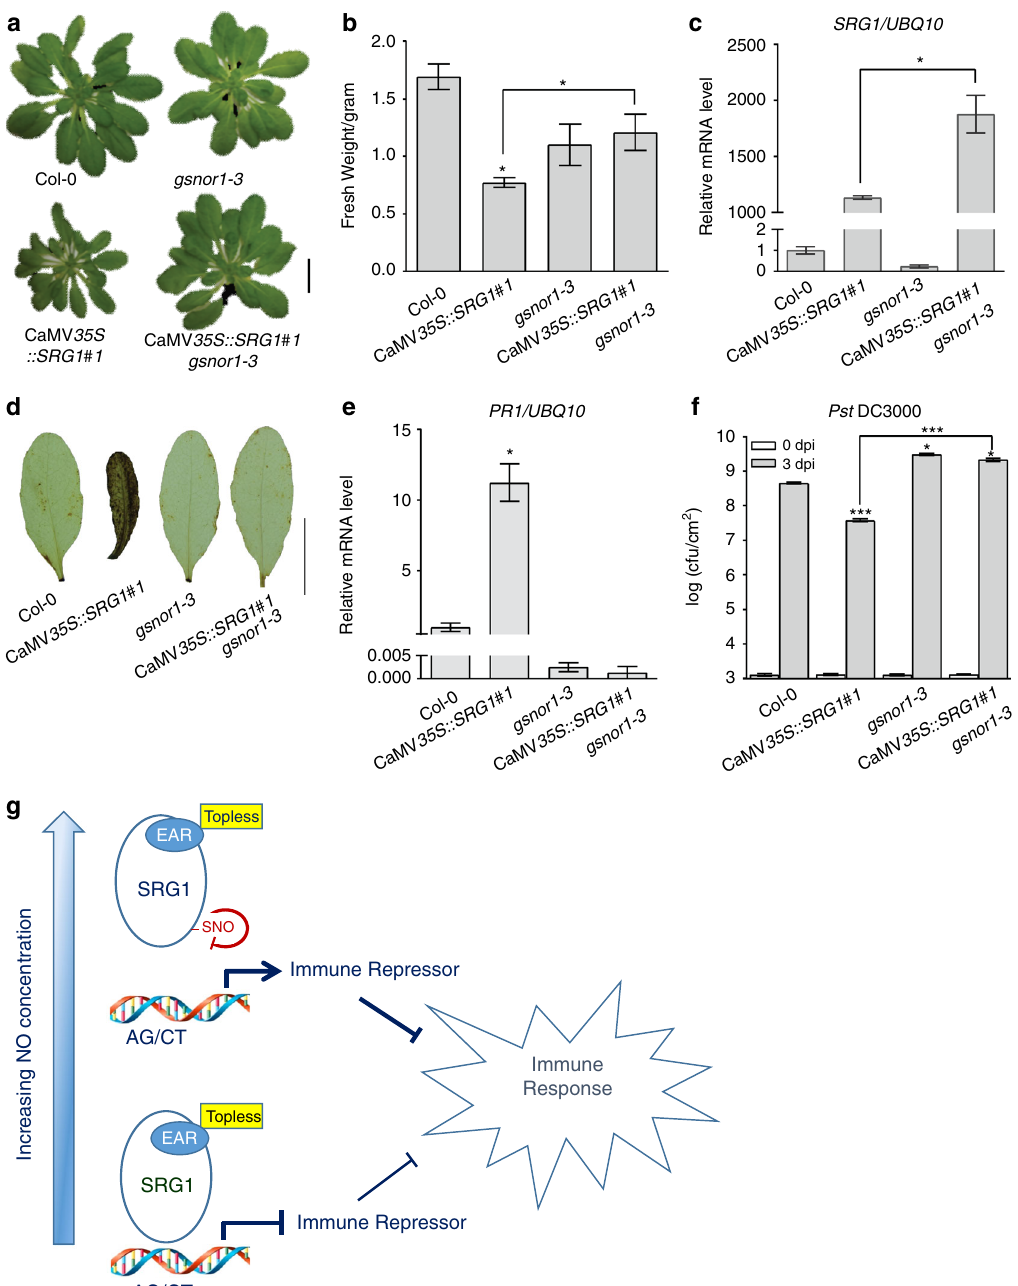
Fig. 6 SRG1 S -nitrosylation negatively regulates immunity. a Morphological phenotype of 6-week-old CaMV 35S :: SRG1 gsnor1-3 plants in comparison to the stated plant lines. Scale bar = 2 cm. b , c The fresh weight ( b ) and SRG1 mRNA level ( c ) of the indicated plant genotypes. d Hydrogen peroxide accumulation was determined by 3,3 ′ -diaminobenzidine (DAB) staining in the given lines. Scale bar = 0.5 cm. e PR1 expression analysis determined by qPCR. The mRNA level of Col-0 wild-type plants was normalized as 1.0. Error bars mean ± SD ( n = 3). Asterisks indicate a signi fi cant difference compared with Col-0 ( t -test, * P < 0.05). f Titre of Pst DC3000 in the given plant genotypes at 0 or 3 days post in fi ltration. Error bars indicate the mean ± SD from at least three independent biological replicates. Asterisks indicates a signi fi cant difference compared to either Col-0 or CaMV 35S::SRG1 with t- test, *** P < 0.001, * P < 0.05. g Model for the function of SRG1 in plant immunity. Upon pathogen recognition, nitric oxide (NO) production induces SRG1 expression. SRG1 contributes to activation of the defence response by suppressing the transcription of one or more immune repressors. As (S)NO levels rise SRG1 becomes S- nitrosylated, blunting its DNA binding activity, enabling the expression of one or more immune repressors, priming a negative feedback loop to